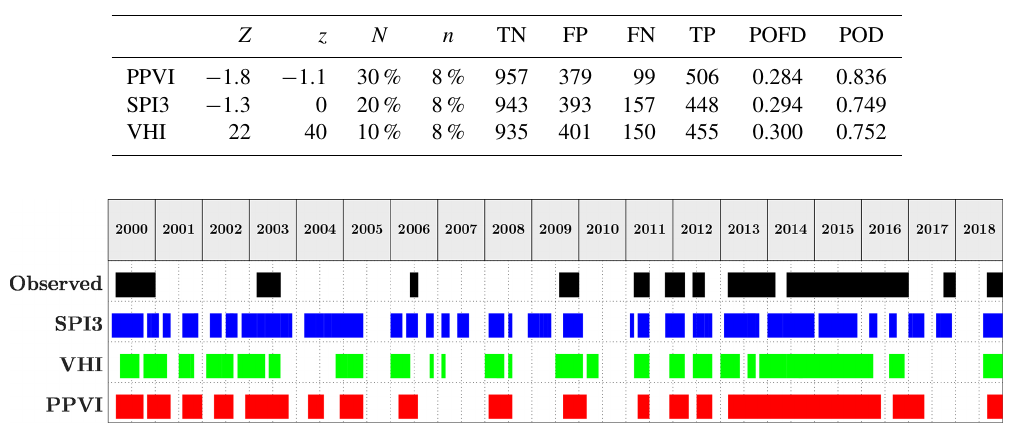
Table 10. Best configuration parameters for the model when applied with the PPVI, SPI3 and VHI.